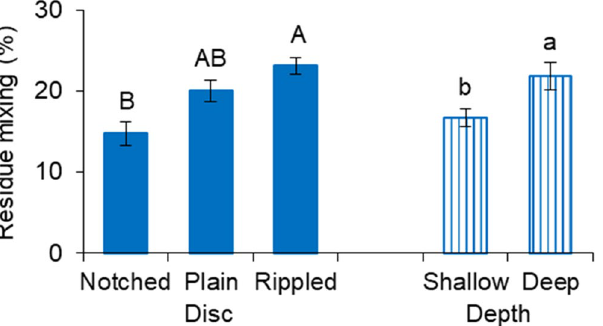
Figure 3. Residue mixing of different discs at different working depths; means followed by different lower case letters or upper case letters are significantly different according to Tukey’s test at the significance level of 0.05; error bars are standard